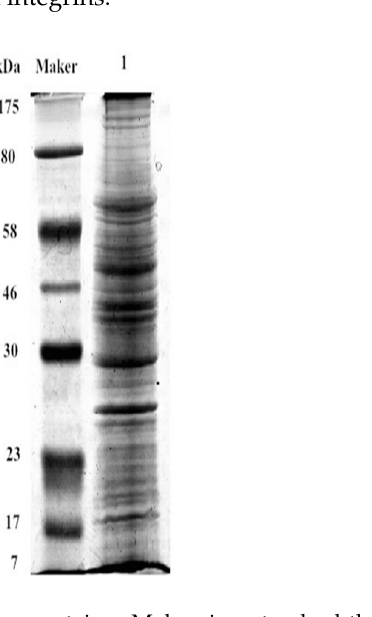
Figure 7. SDS-PAGE of IPEC-J2 membrane proteins. Maker , is a standard that is used to identify the approximate size of a molecule run on a gel during electrophoresis; Lane 1 represents membrane proteins, SDS-PAGE. Table 1. Identification of SBA receptors by Q–E analysis.